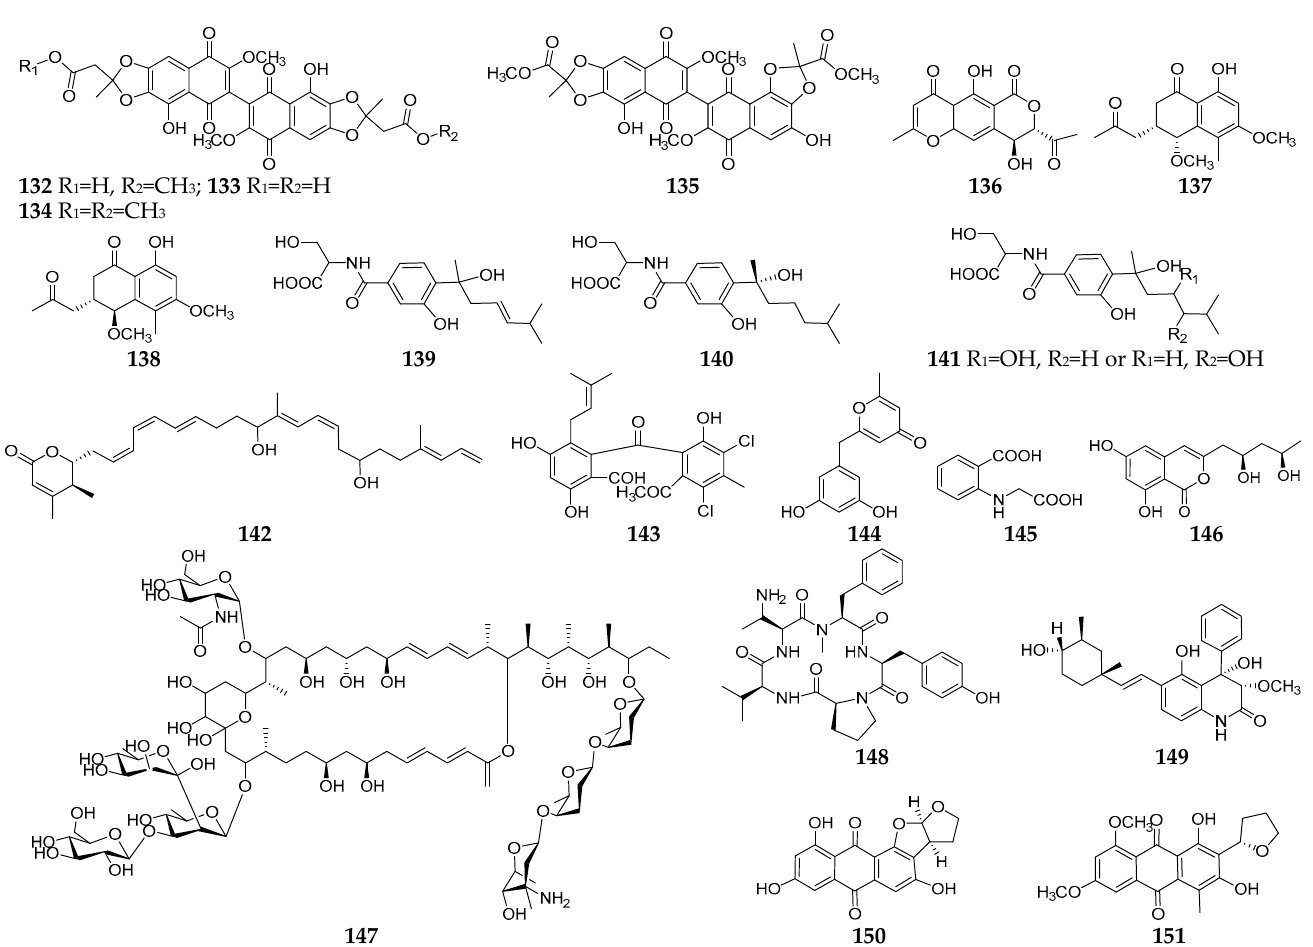
Figure 8. New SMs ( 132 – 151 ) isolated from fungal–bacterial co-culture using SSF.